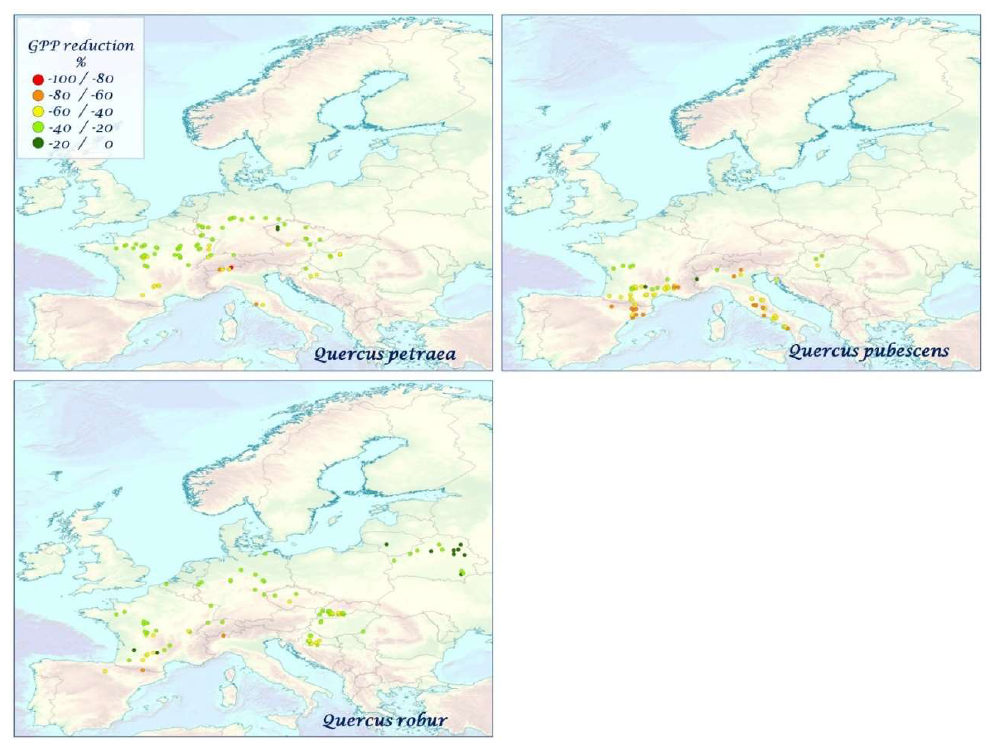
Figure 9. The mean species–specific GPP reduction (%) for Q. petraea , Q. pubescens , Q. robur over the time period 2000–2010.